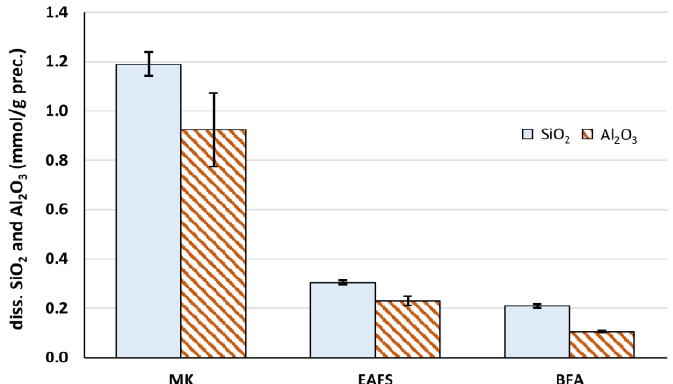
Figure 5. Dissolved amount of SiO 2 and Al 2 O 3 from each precursor, determined in the alkaline dissolution tests.